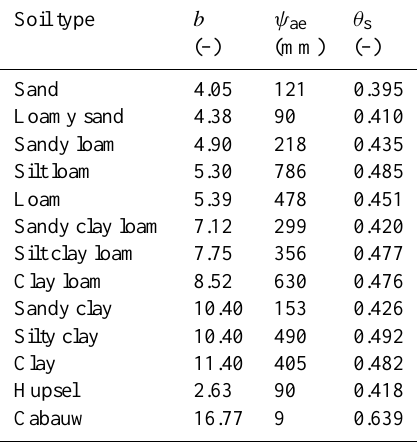
Table 2. Parameters of the Brooks–Corey equilibrium soil mois- ture profile. The first 11 rows are taken from Clapp and Hornberger (1978). The last two lines are obtained from combined soil mois- ture and groundwater observations in the two catchments (see also Fig.